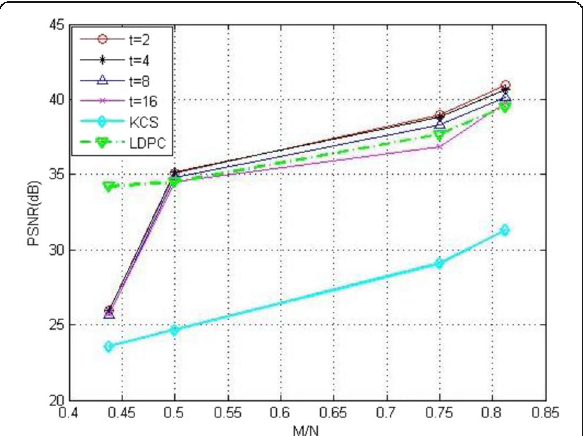
Fig. 6 Comparison of performance with other low-memory techniques. (Lena, ℓ 0 -minimization with ρ = 0.8). t = 2, 4, 8, and 16 were obtained from ℓ 0-minimization per our proposal, where ρ = 0.8; KCS was